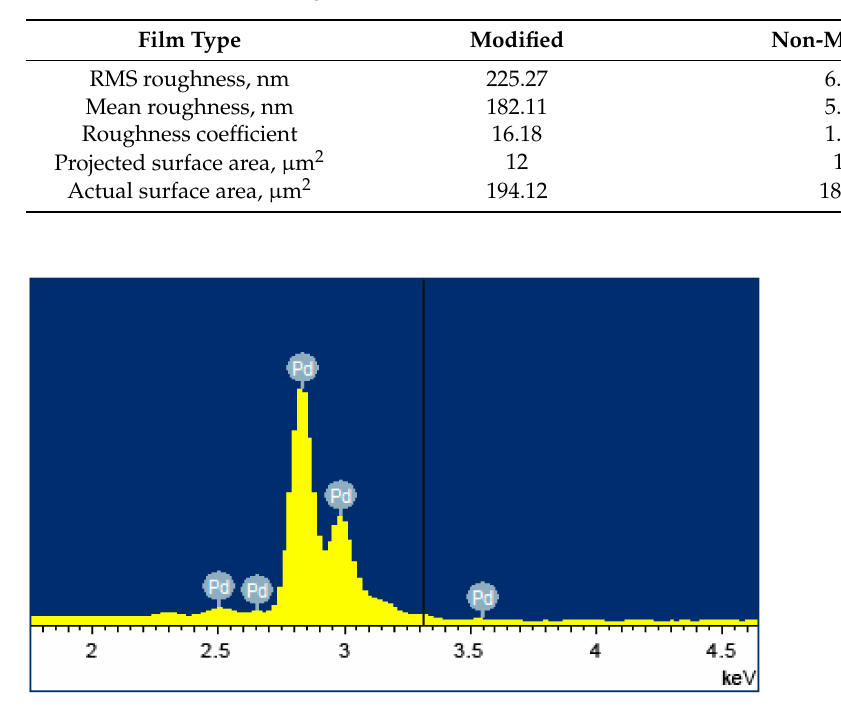
Figure 2. Elemental composition spectrum of the modified PdCu–Nb–PdCu film sample. The thicknesses of protective Pd–Cu and catalytic nanostructured palladium layers deposited on niobium foil were estimated using microphotographs of sections taken on a JEOL JSM-7500F scanning electron microscope. As shown in Figure 3 data, the thickness of the smooth protective layer was 1.1 µ m, the thickness of the modifying nanostructured layer was 0.8 µ